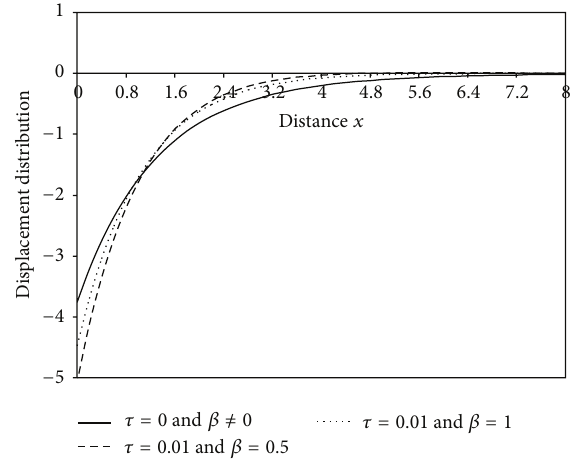
Figure 1: Profile of displacement distribution.